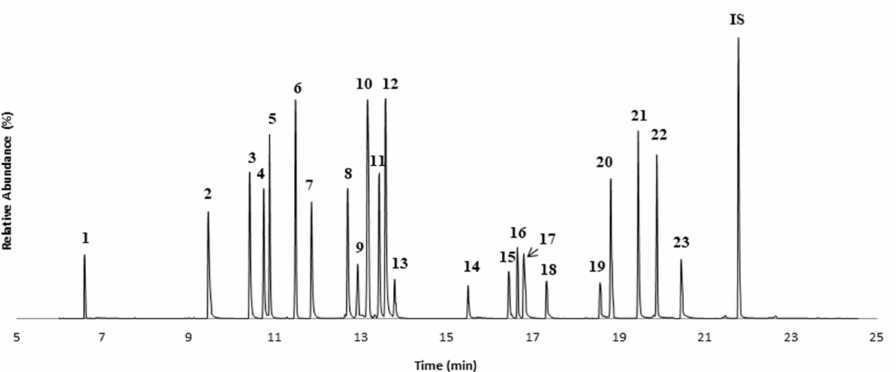
Figure 3. Typical chromatogram in the SIM mode for 1 g of skimmed cow milk spiked with a 500 ng/kg concentration of each EDC. 1, dichlorvos; 2, methylparaben; 3, ethylparaben; 4, iso- propylparaben; 5, 2-phenylphenol; 6, 4- tert -octylphenol; 7, propylparaben; 8, isobutylparaben; 9, dimethoate; 10, nonylphenol; 11, butylparaben; 12, 4-phenylphenol; 13, diazinon; 14, parathion methyl; 15, malathion; 16, chloropyrifos; 17, fenthion; 18, bromophos methyl; 19, methidathion; 20, triclosan; 21, benzylparaben; 22, bisphenol A; 23, fenthion sulphoxide; IS, internal